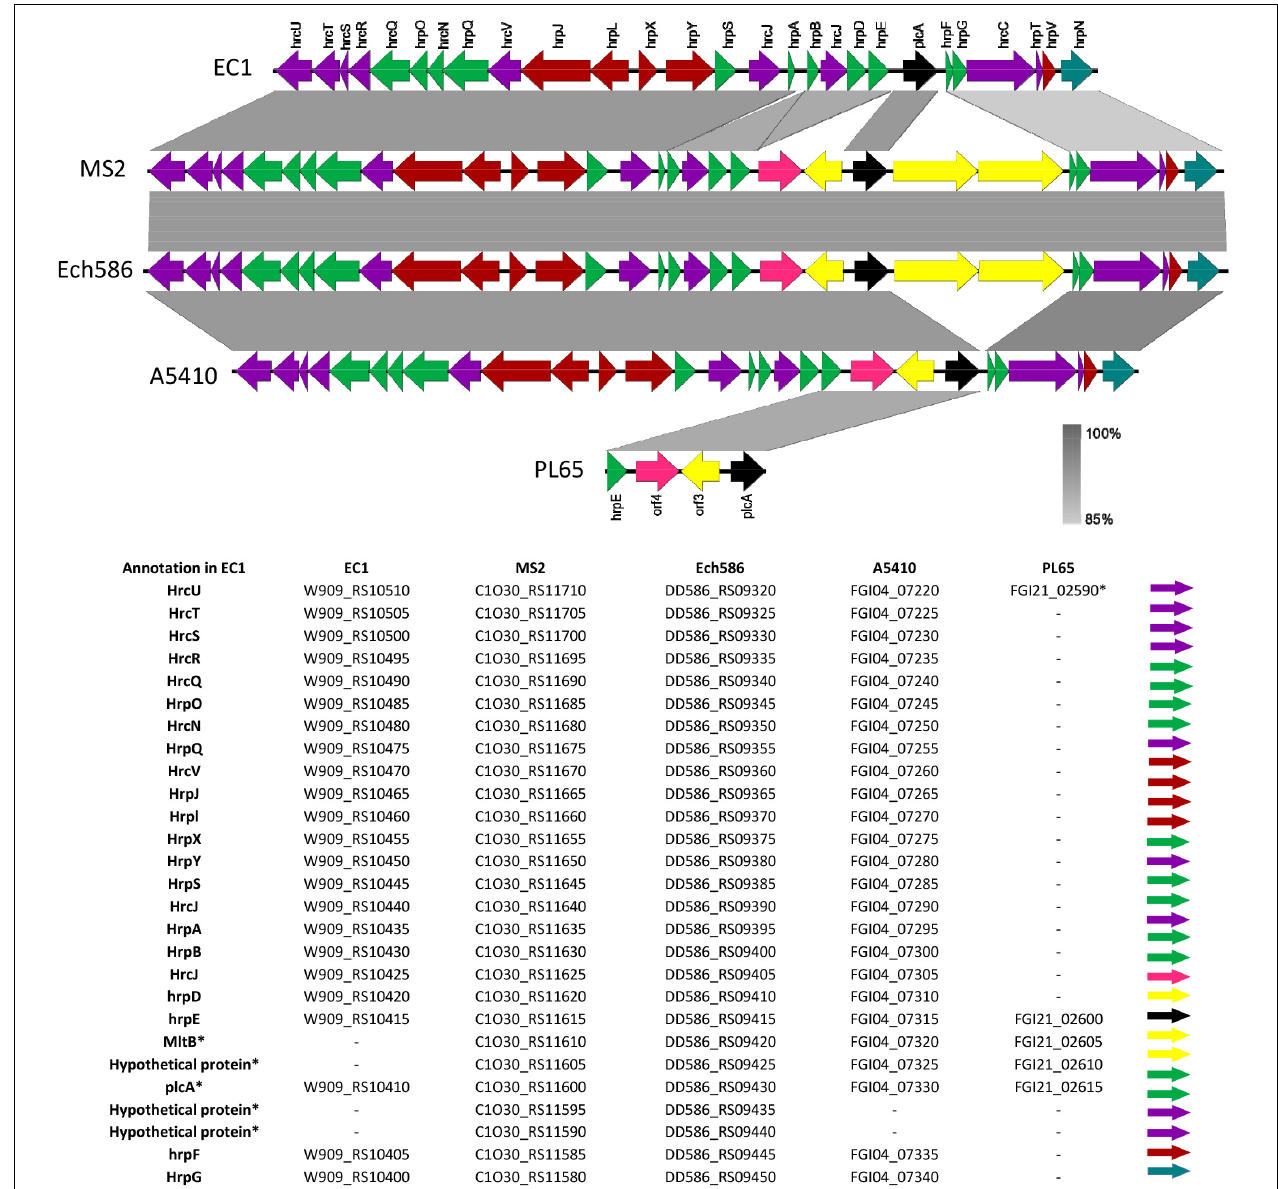
FIGURE 9 | Comparison of the genetic organization of type III secretion system (T3SS) among five D. zeae strains. The arrow position represented a forward/reverse gene orientation. The arrow color signified a specific gene composition within the T3SS. A pairwise alignment between the linear sequences was rendered based upon the BLAST algorithm with cut-off values from 85 to 100%. Regions with a higher nucleotide identity were displayed with a shaded